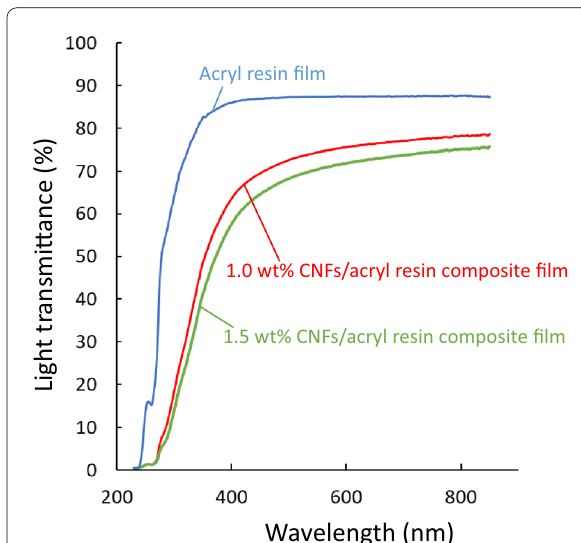
Fig. 4 Light transmittance of acryl films with and without CNFs